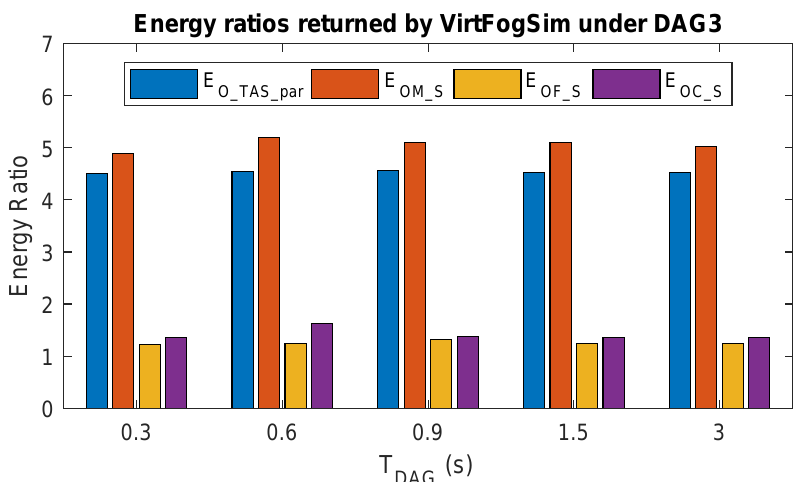
Figure 12. Energy ratios returned by VirtFogSim under DAG3 for T DAG = 0.3 s, 0.6 s, 0.9 s, 1.2 s, and 1.5 s. All the reported ratio values are normalized with respect to the corresponding total energies consumed by GeneticTA_par